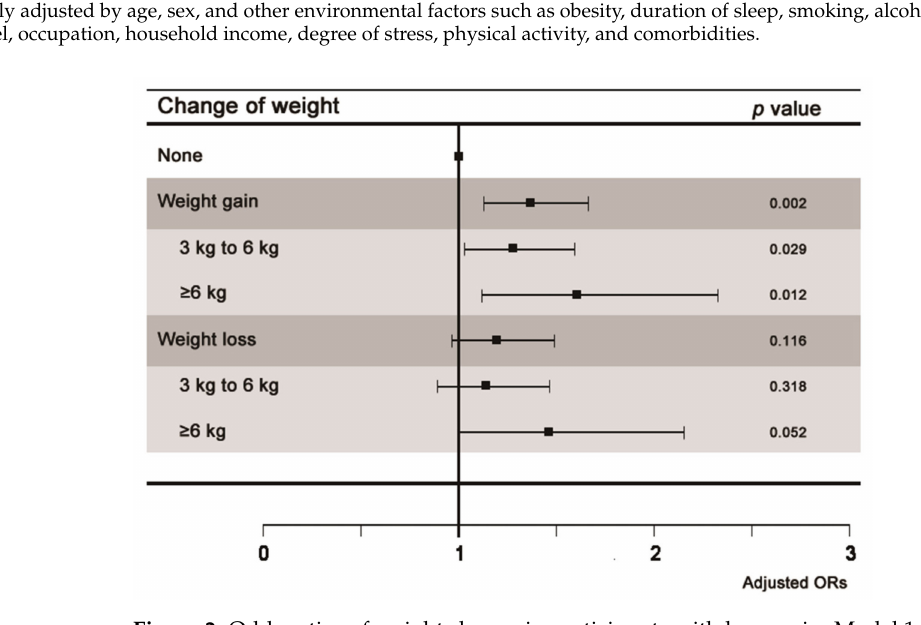
Figure 2. Odds ratios of weight change in participants with knee pain. Model 1, unadjusted; Model 2, adjusted for sex and age; Model 3, adjusted for age, sex, and other factors such as obesity, duration of sleep, smoking, alcohol consumption, educational level, occupation, household income, degree of stress, physical activity, and comorbidities. CI, confidence interval; OR, odds